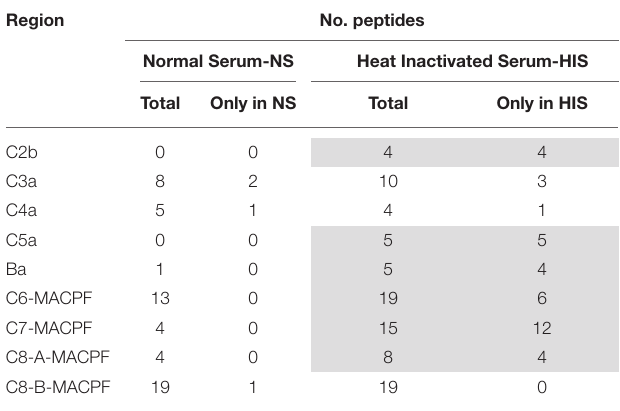
TABLE 5 | Analysis of peptides corresponding to cleavage fragments produced during complement activation and to contact regions in MAC